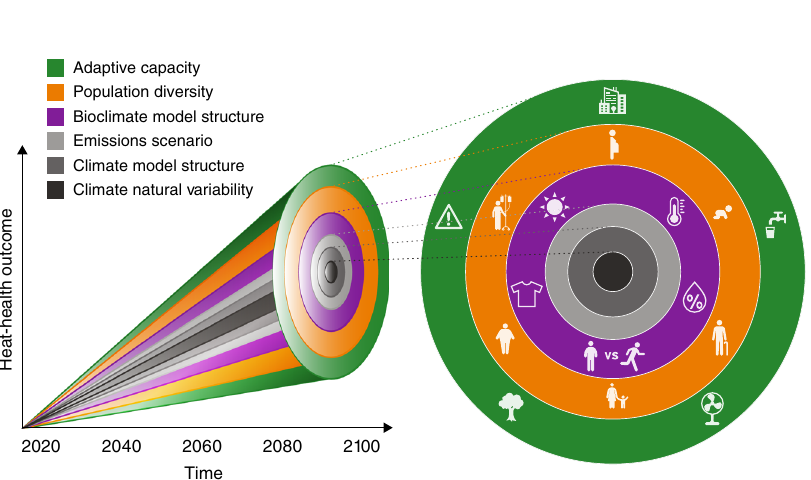
Fig. 1 Uncertainties in projections of human health, well-being, and productivity due to extreme heat exposure in a warming climate. The left side of the fi gure shows that in addition to uncertainties regularly quanti fi ed in projecting environmental variables (climate variability, model structure, and emissions scenario), there are further uncertainties in projecting heat-health outcomes including bioclimate model structure (examples in Table 1), diversity and vulnerabilities in the population, and various adaptations to heat (e.g., warning systems, behavior, urban planning). This plot is intended to be illustrative rather than quantitative — the respective magnitude of these additional sources of uncertainty remains unknown. The right side provides graphics of these sources of uncertainty in projecting human heat-health outcomes, with the concentric circle colors corresponding with the colors of uncertainty cones in the left side. These graphics represent inputs to bioclimate models, including solar radiation, temperature, humidity, clothing, and activity; considerations for population diversity, such as pregnancy, age, weight, and pre-existing illness; and various forms of adaptive capacity, such as building design, hydration, fans or air conditioning, green infrastructure, and the implementation of heat warnings